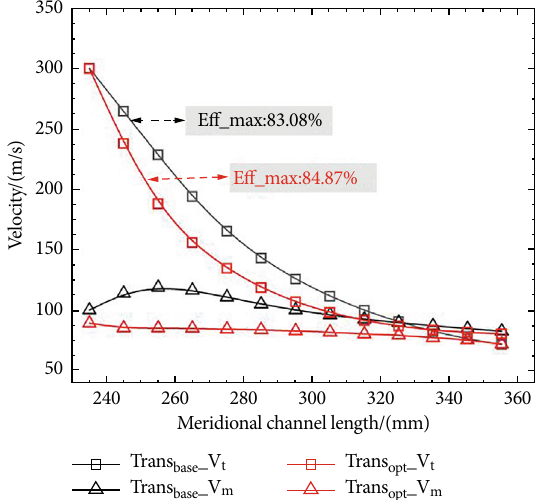
Figure 13: Velocity distributions for the di ff user of the transonic compressor.